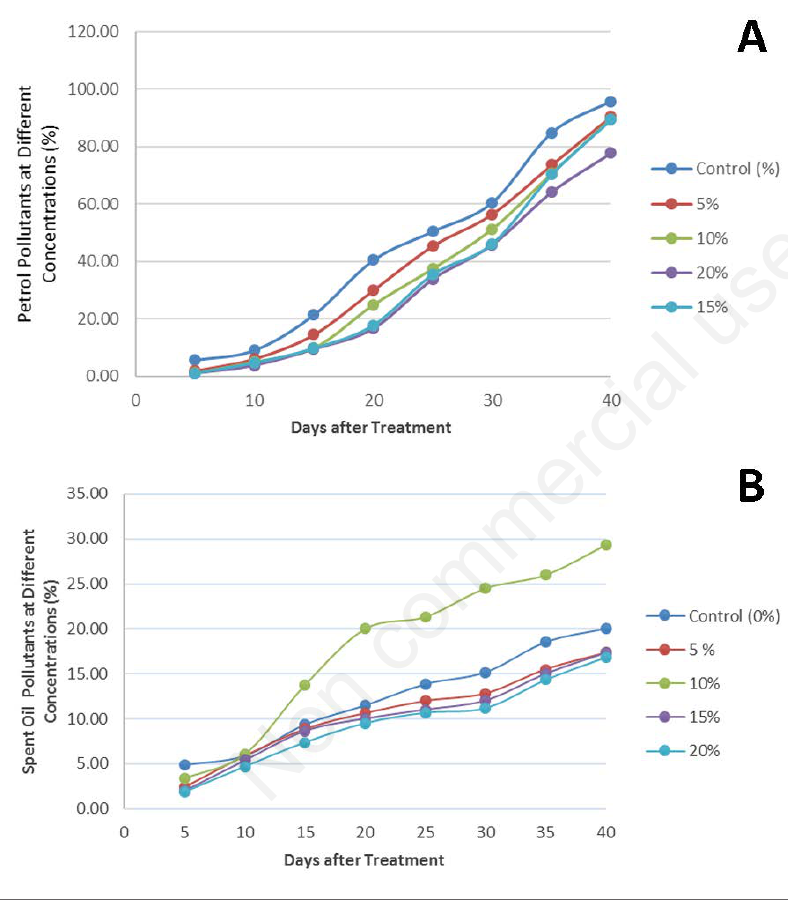
Figure 1. Graph of A) petrol pollutant and B) spent oil against days after treatment.